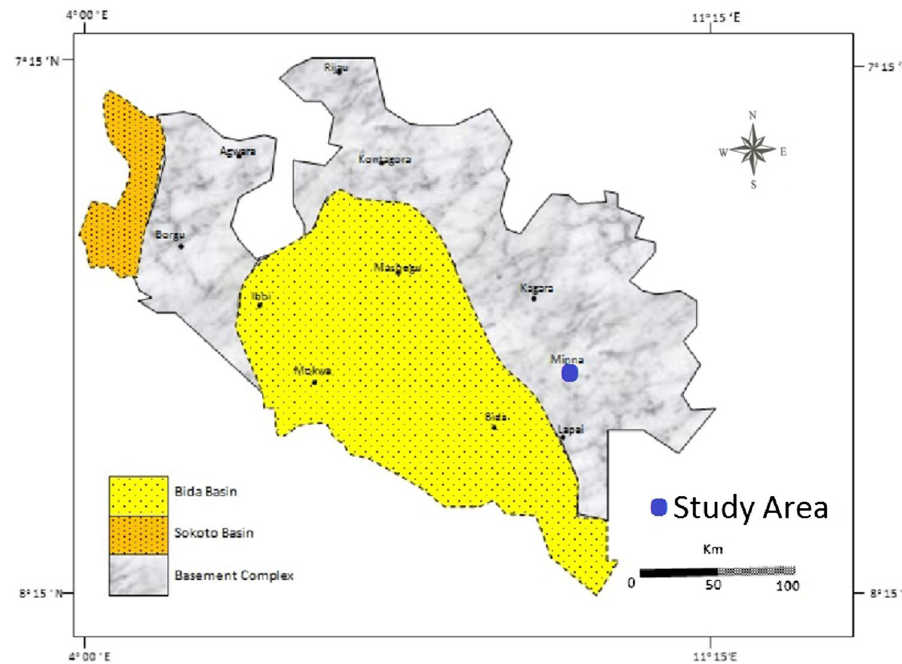
Fig. 1 Geological map of Niger state showing basement complex and sedimentary basin (Amadi et al.